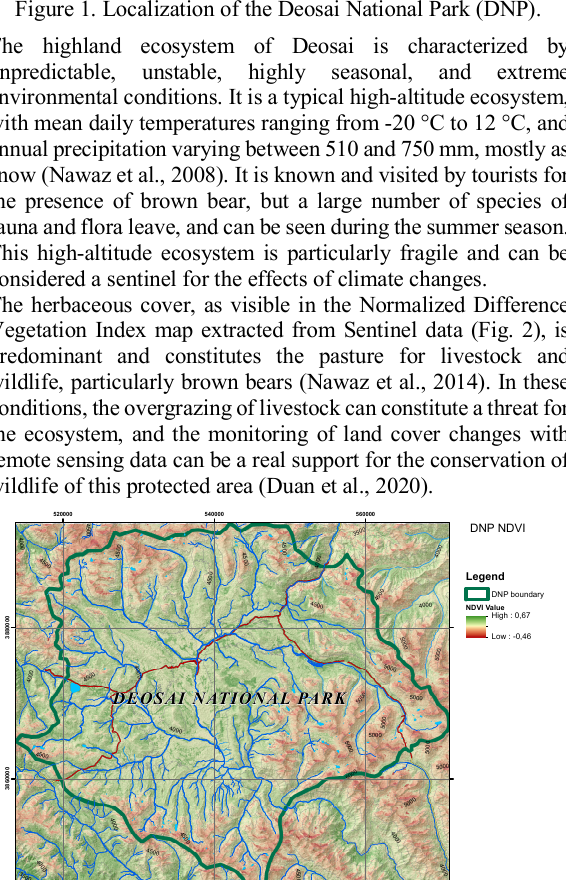
Figure 1. Localization of the Deosai National Park (DNP).